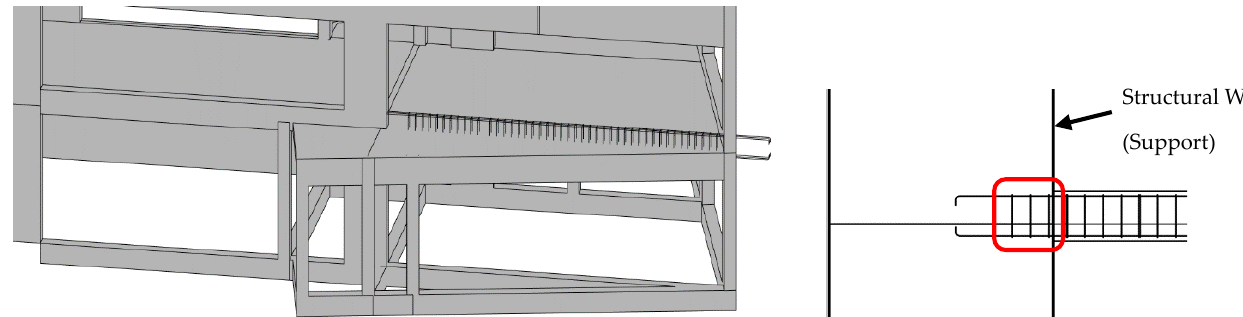
Figure 15. Errors in the transfer reinforcement in beam elements.